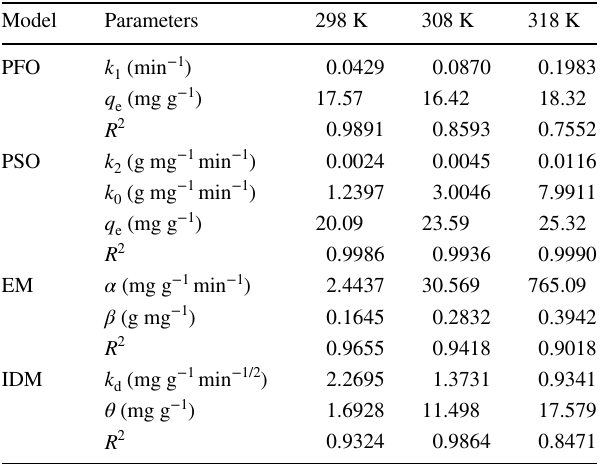
Table 2 Model parameters calculated for various kinetic models at different temperatures (initial concentration: 70 mg L −1 ) Model